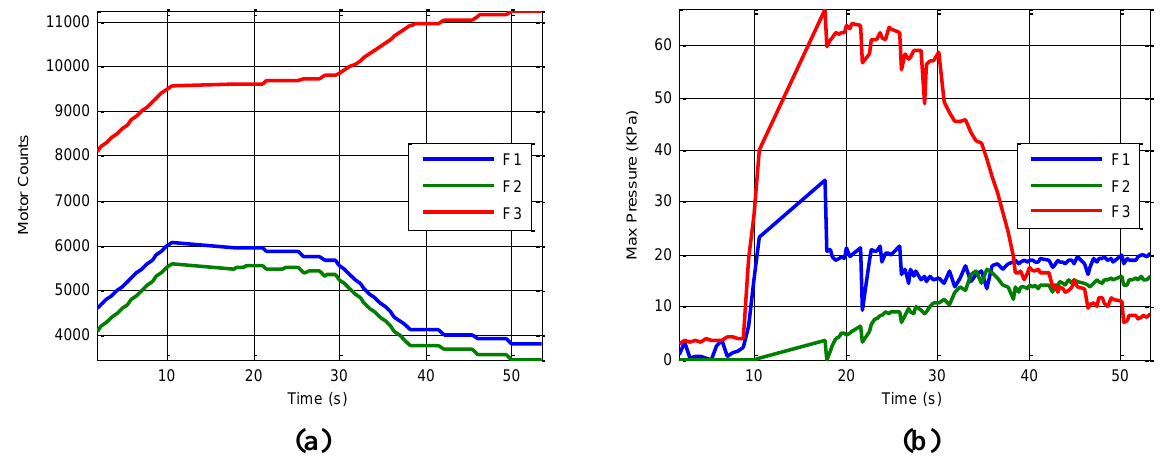
Figure 12. Evolution of fingers’ parameters during the execution of the manipulation task: (a) motor counts; and (b) maximum contact